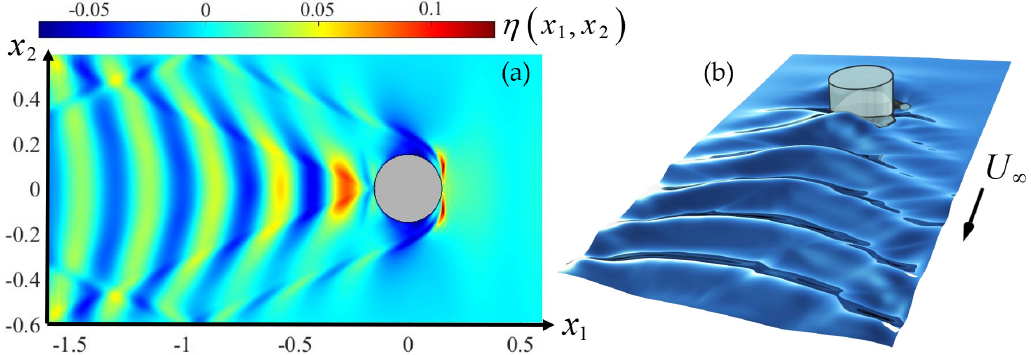
Figure 4. ( a ) Color plot and ( b ) rendered view of the free surface elevation generated by the steady perturbation field for one cylindrical scatterer of diameter D = 0.3m, h = 1m, U ∞ = ( − 0.7,0,0 )